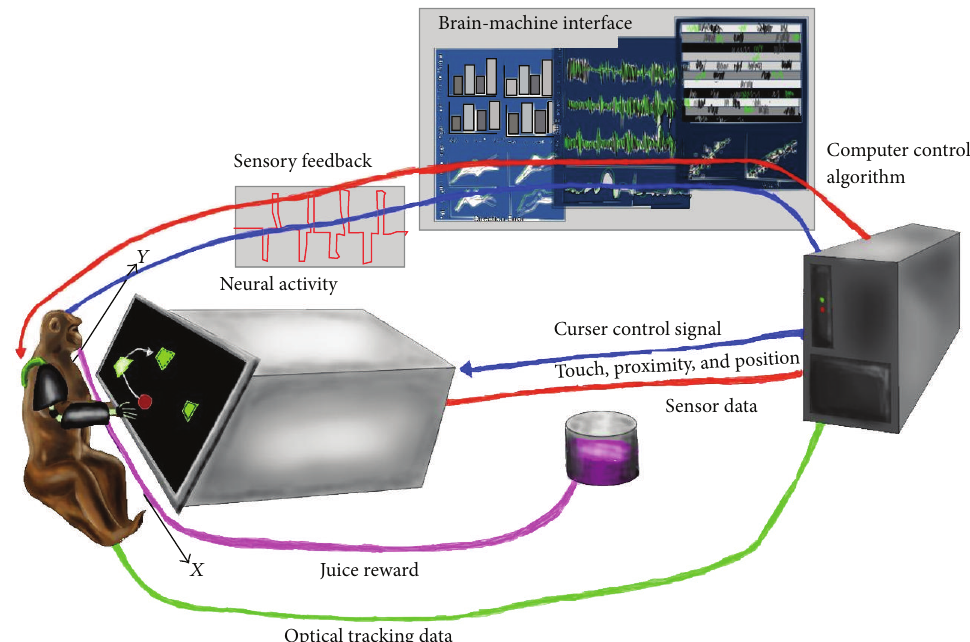
Figure 2: Illustration that depicts the set-up using an exoskeleton to incorporate proprioception into the mind controlled computer curser operated by the monkey